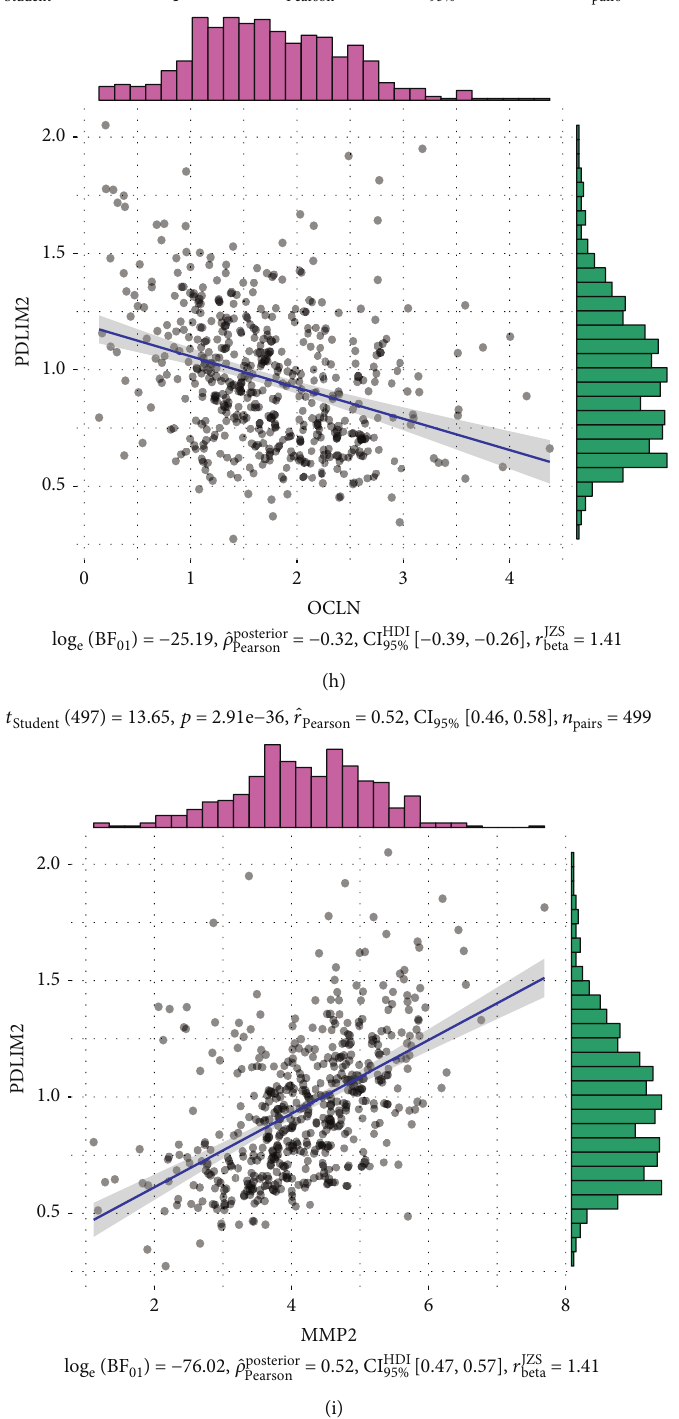
Figure 6: PDLIM2 mRNA is involved in EMT process in prostate cancer patients. (a) The mRNA expression level of PDLIM2 was correlated with various EMT signatures and EMT-related genes. EMT_1, Chen et al. 2013; EMT_2, Klarmann et al. 2009; EMT_3, Mathews et al. 2010; EMT_4, Schell et al. 2016; EMT_5, Sethi et al. 2010; EMT_6, Stylilanou et al. 2019. (b) Heatmap showing the relationship between EMT signature-related genes and PDLIM2 expression. (c) Kaplan – Meier survival analysis showed the EMT signature reported by Mathews et al. was signi fi cantly associated with poor PFI in patients with prostate cancer. (d – i) The correlation between PDLIM2 mRNA expression land EMT biomarkers, including TJP1, DSP, VIM, CDH1, OCLN, and MMP2 in prostate cancer